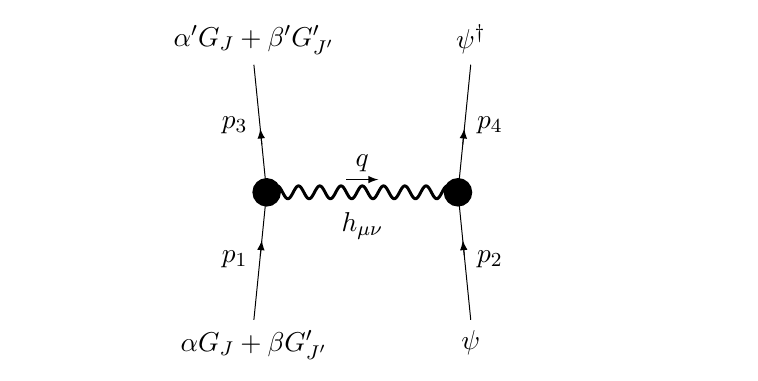
Figure 8 . A setup to bound the graviton induced mixing. The leading non-trivial contribution still comes from a graviton